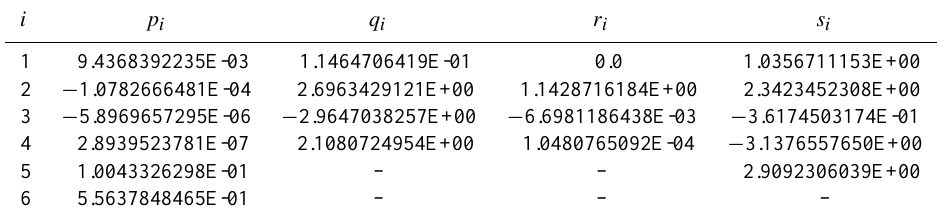
Table 1. Coefficients p i , q i , r i , and s i for the approximation functions ˆ c 1 (a) ... ˆ c 4 (a) in Eq. (14).